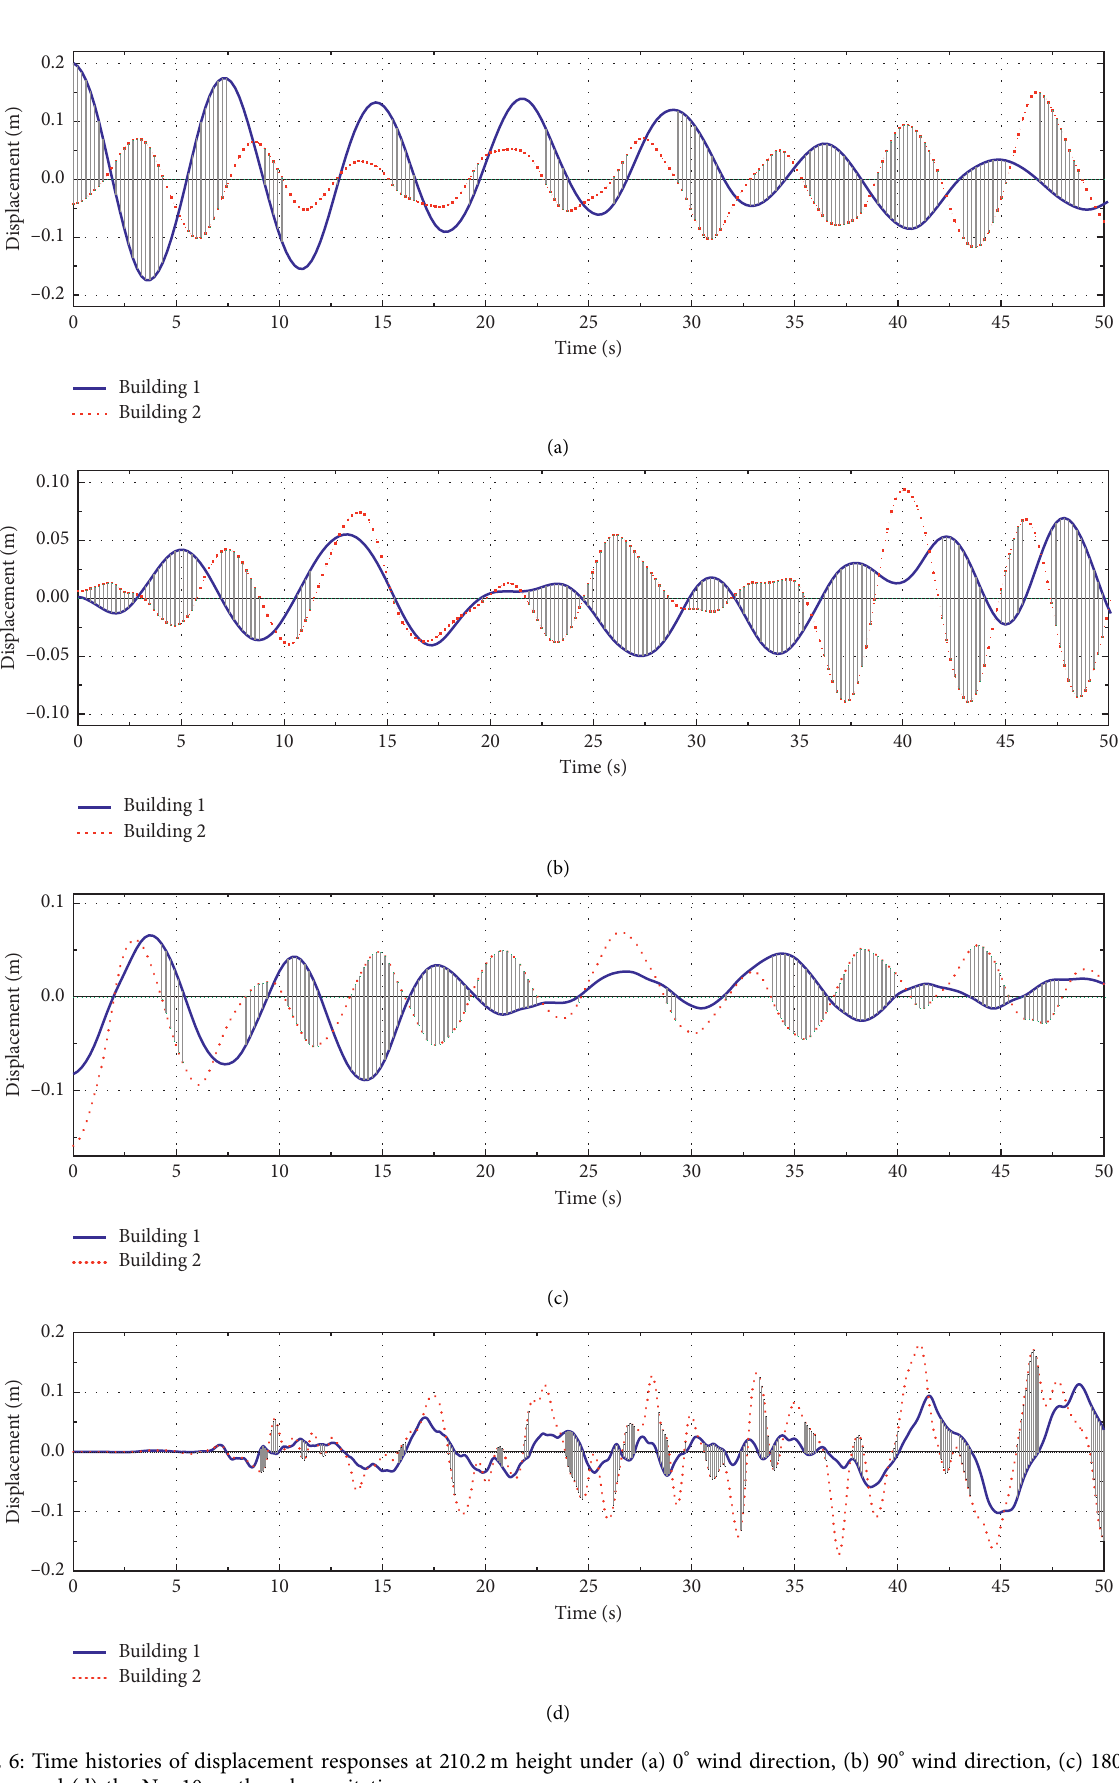
Figure 6: Time histories of displacement responses at 210.2m height under (a) 0 ° wind direction, (b) 90 ° wind direction, (c) 180 ° wind direction, and (d) the No. 10 earthquake